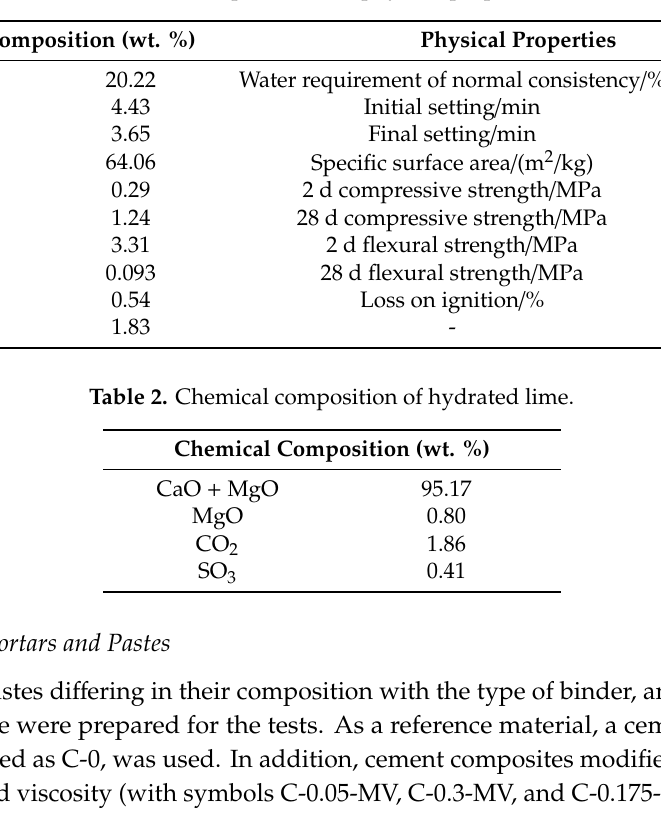
Table 1. Chemical composition and physical properties of cement.